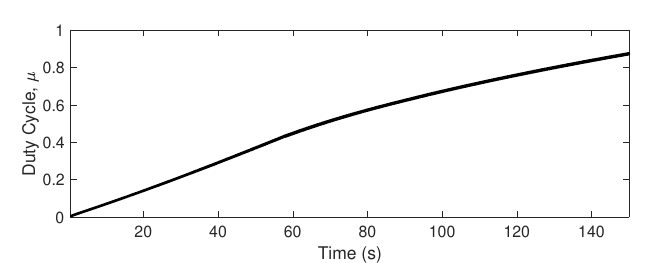
Figure 12. Duty cycle during the charging process.